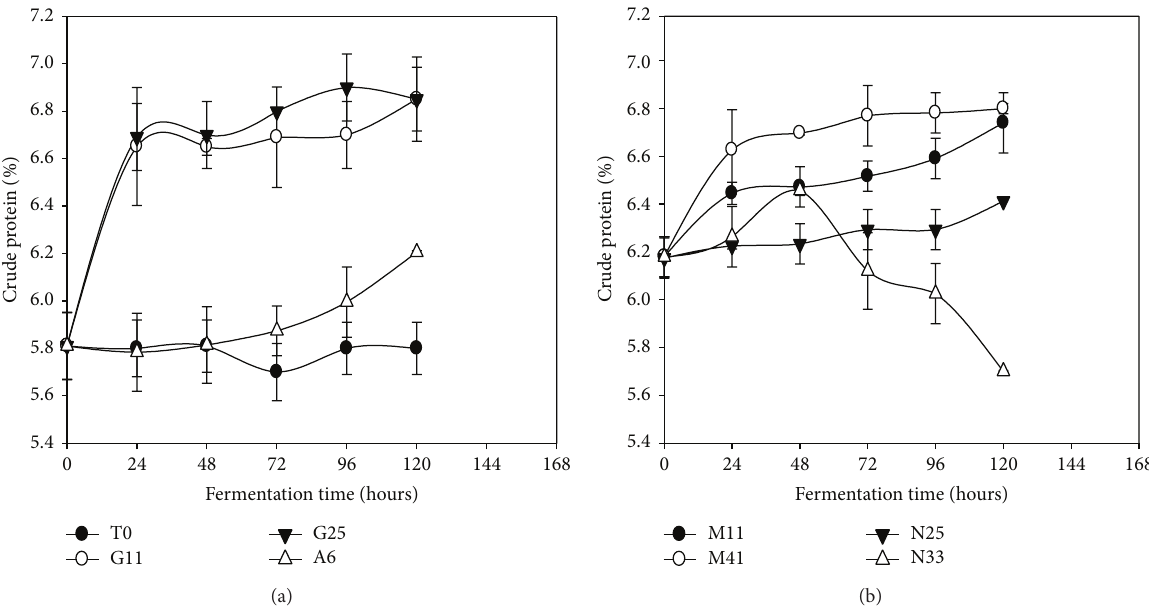
Figure 5: Evolution of the crude proteins content in Kutukutu during fermentation by the various LAB at 25 ∘ C (T0 = control; G11 = L. brevis G11; G25 = L. brevis G25; A6 = L. plantarum A6; M11 = L. buchneri M1; M41 = L. cellobiosus M41; N33 = L. fermentum N33; N25 = L. fermentum